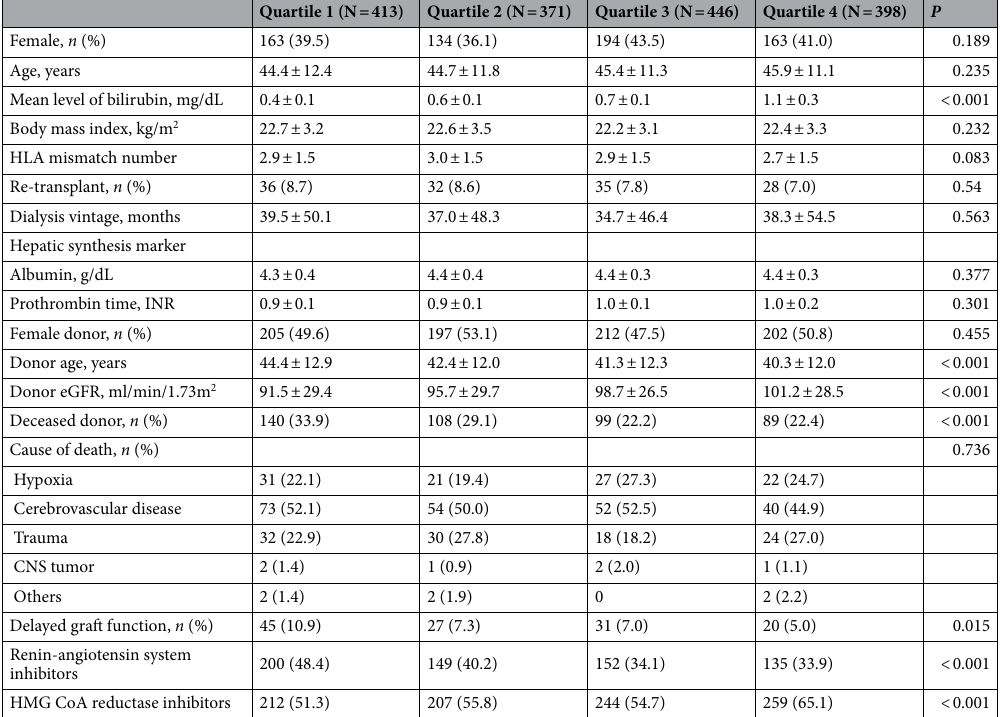
Table 1. Baseline characteristics of patients, stratified by sex-specific serum bilirubin levels.